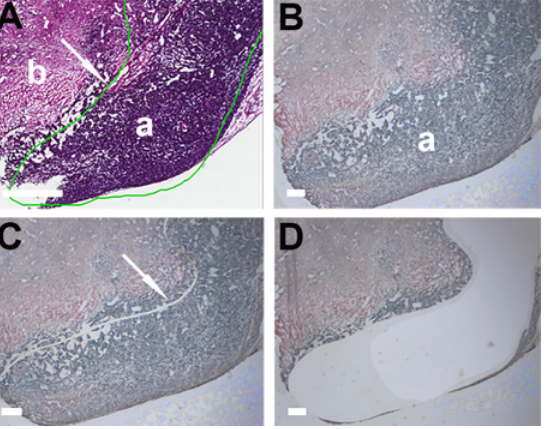
Fig 1. Pathology annotations of target area and documentation of carcinoma dissection by laser cutting. (A) Target area, carcinoma (a), was annotated by study pathologist on a digital image of reference H&E section of mammary gland (b) by green line (arrow); (B) View of LCM section with target area (a) on the dissecting screen of MMI CellCut microdissection instrument; (C) Dissecting screen view of the carcinoma area with the laser cut path (arrow); (D) Dissecting screen view of carcinoma area after retrieval of target cutout. A: Scale bar corresponds to 650 μ m; B-D: Scale bars correspond to 300 μ m.